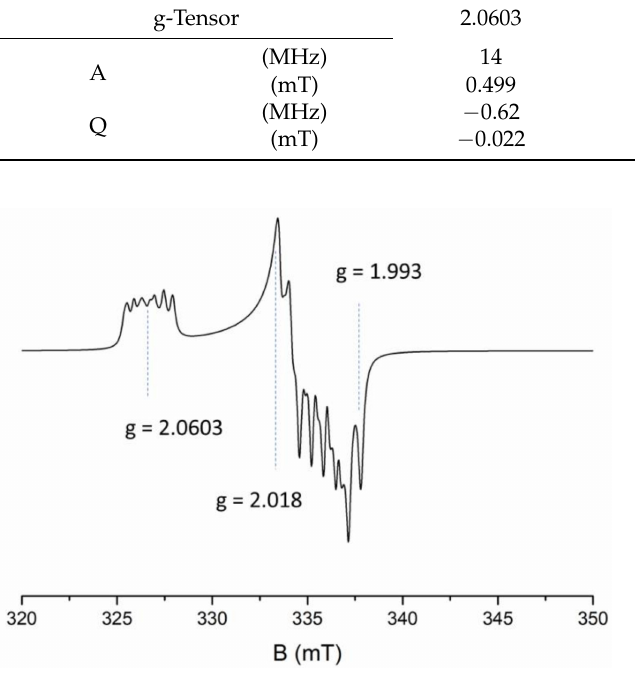
Figure 1. A simulated EPR signal of the Al-h centre with the g-factor values mentioned in the text. The parameters used for simulation are listed in Table